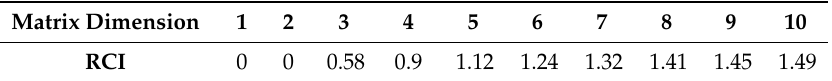
Table 2. Random consistency index